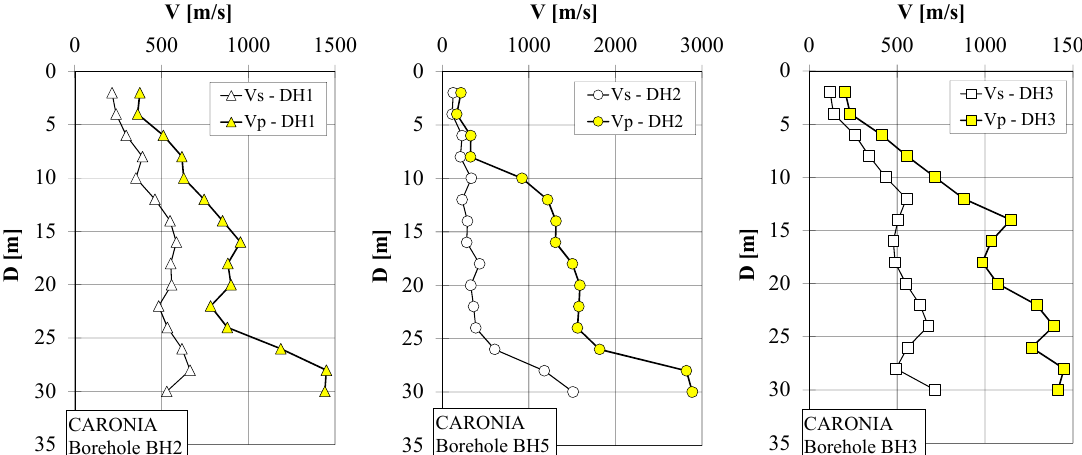
Figure 7. V s and V p from down-hole tests in Caronia area, where: V s = Shear wave velocity and V p = Compression wave velocity. In Figure 8, the dynamic Poisson ratio ( ν ) variation with depth, obtained from the Down-Hole (DH) test, is plotted to show site characteristics. It is shown that the values oscillate around 0.03–0.48 for DH.